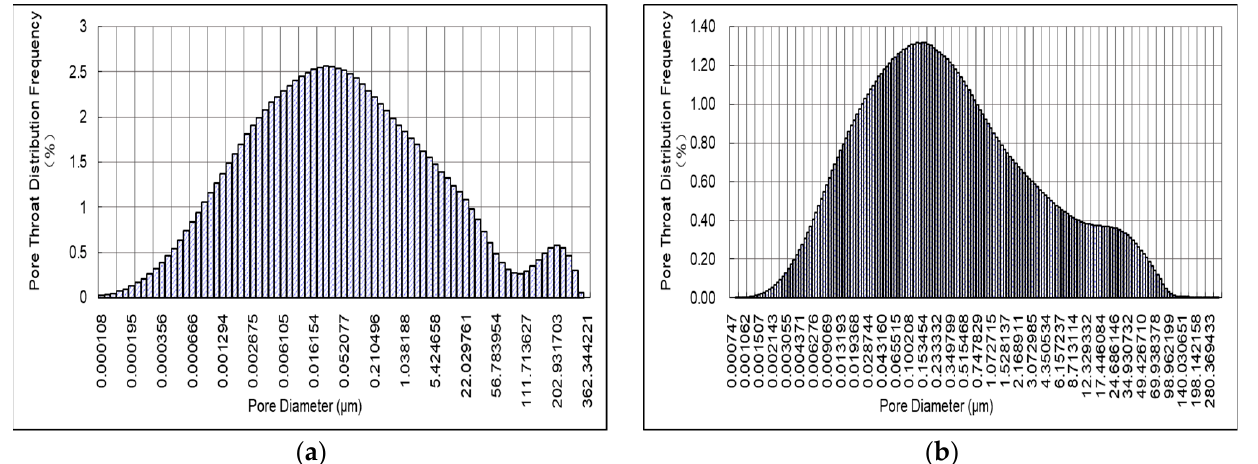
Figure 6. Distribution of core pore size (No. 19 of Well XX1003): ( a ) before fracture; ( b ) After fracture.